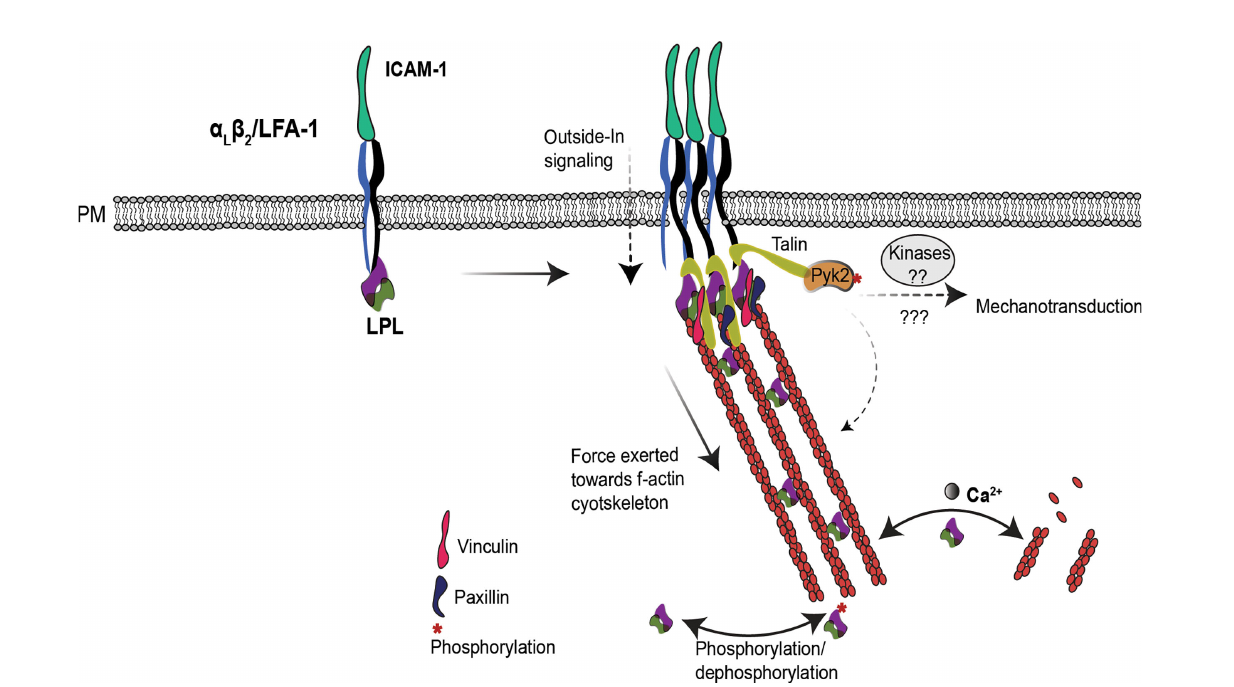
FIGURE 2 | LPL may regulate T cell integrins induced mechanotransduction. In T cells, LPL binds to LFA-1. Under certain conditions, e.g. shear fl ow or ICAM-1 engagement, LFA-1 shifts to the extended-open (high-af fi nity) conformation. LPL binding to LFA-1 recruits the mechanosensing protein Talin, and also connects it to the f-actin cytoskeleton. Talin recruits additional cytoskeleton-associated proteins, such as vinculin, paxillin and the tyrosine kinase Pyk2. Collectively, this cascade generates mechanotransduction through Pyk2 and other kinases, and triggers f-actin remodeling required for ef fi cient T cell activation and migration. The separable activities of LPL – LFA-1 binding, f-actin binding, and f-actin-bundling — are coordinately regulated to support mechanotransduction. How the multiple regulatory sites on LPL (phosphorylation, Ca 2+ , and calmodulin-binding) converge to modulate the varied activities of LPL are yet to be